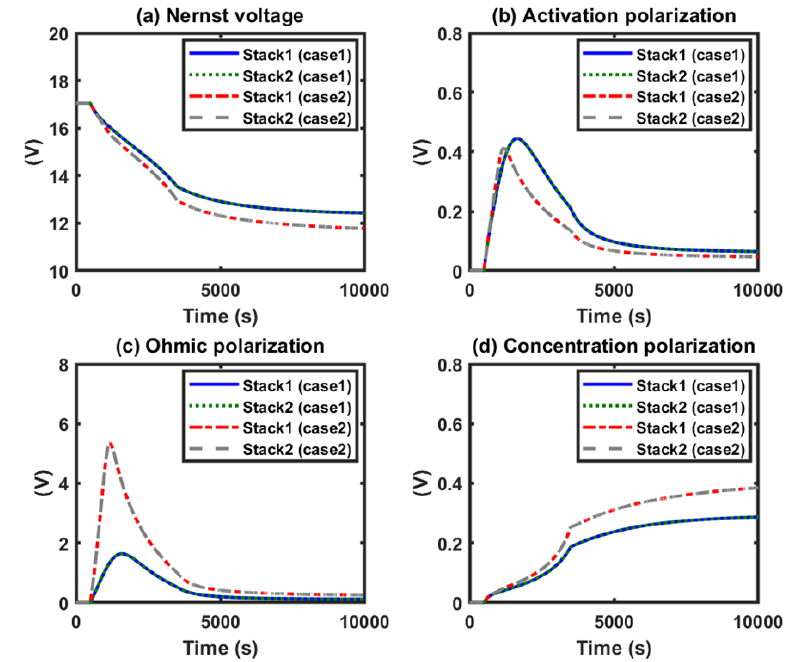
Figure 5. Transient response of the stack voltages when the two employed FC stacks are the same. Case 1: stacks have a small ohmic loss. Case 2: stacks have a large ohmic loss. ( a ) Nernst voltage, ( b ) activation polarization, ( c ) ohmic polarization, and ( d ) concentration polarization.